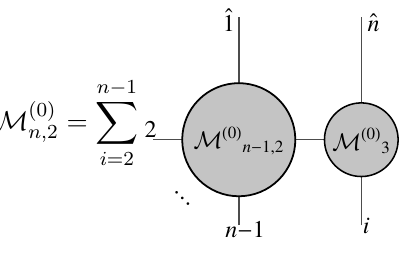
Figure 22 . BCFW recursion for tree-level MHV amplitudes in N = 8 SUGRA.